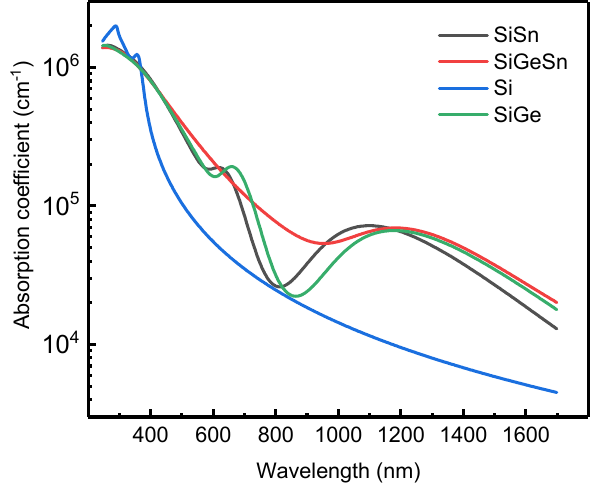
Figure 7. Absorption coefficient of SiGe, SiSn, and SiGeSn alloys fabricated by ion beam implantation at the 200–1700 nm range compared to the referenced Si (001) sample, measured using spectro- scopic ellipsometry.